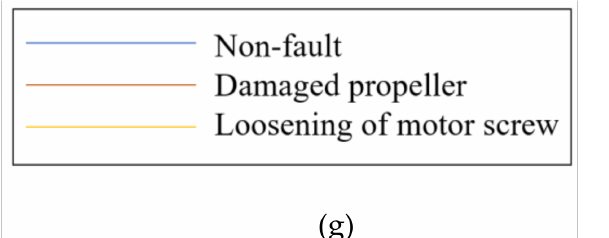
Figure 5. The features of vibration and PWM signal data: ( a ) average data from the accelerator; ( b ) sample entropy data from the accelerator; ( c ) standard deviation data from the accelerator; ( d ) RMS data from motors; ( e ) average data from motors; ( f ) standard deviation data from motors; ( g ) representation of colors.